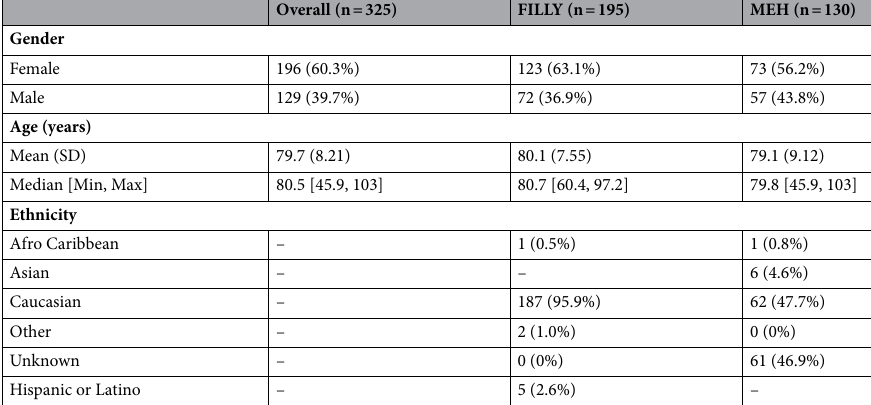
Table 1. Cohort demographics. Mean, median, minimum value, maximum value, standard deviation (SD), and proportional distributions are shown for gender, ethnicity, and age of cohorts including patients with geographic atrophy secondary to non-neovascular AMD. Patients were recruited as part of an international, multicentre trial (FILLY) or retrospectively through real-world clinical care at Moorfields Eye Hospital (MEH). Direct comparison of ethnicity was infeasible as each cohort represented ethnicities with distinct categorical variables that could not be intuitively